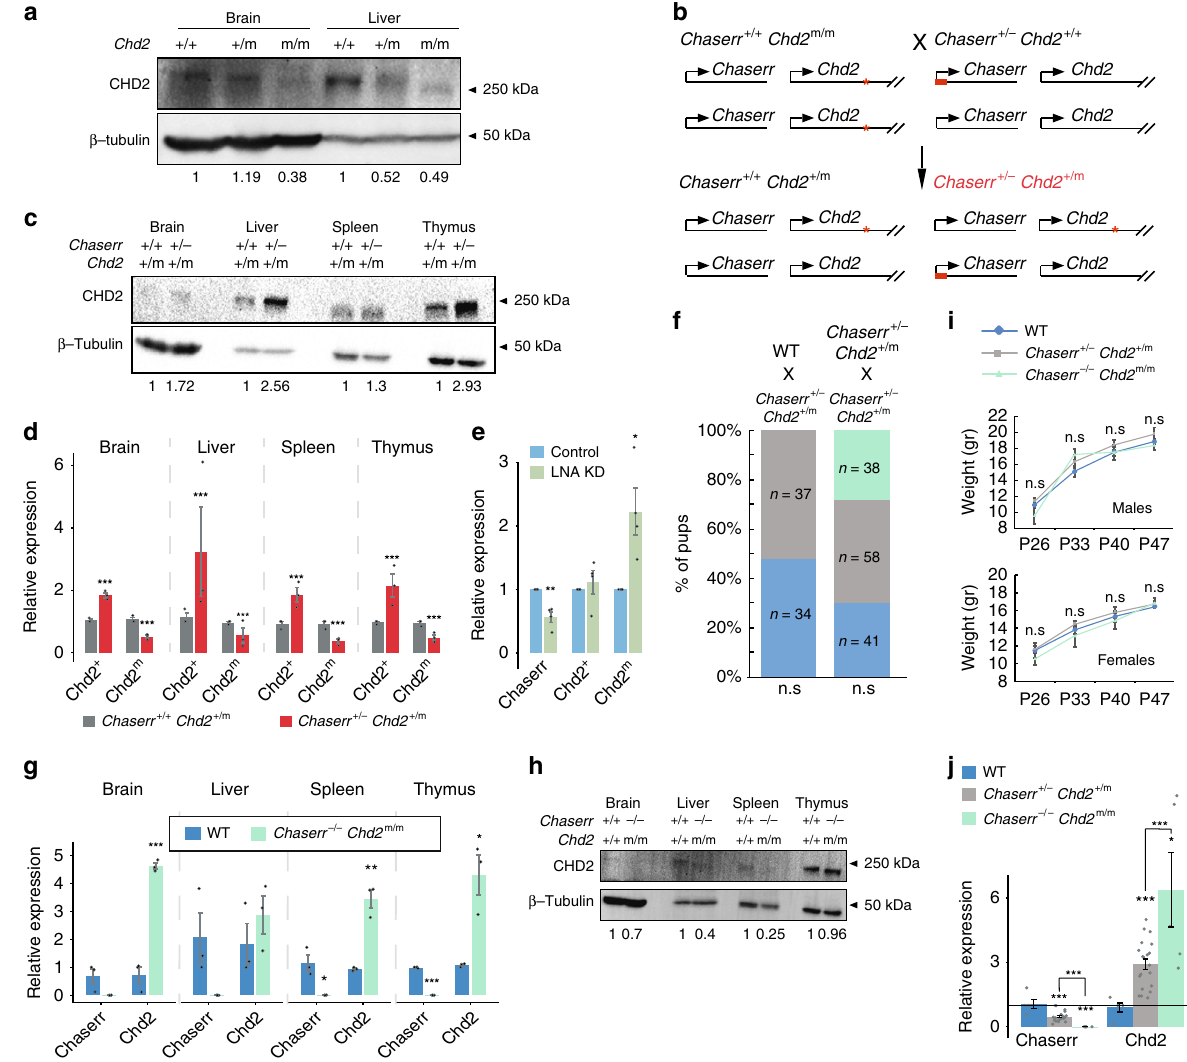
Fig. 3 Chaserr regulates Chd2 expression in cis . a CHD2 Western blot in the indicated tissues from mice with the indicated genotypes. b Scheme of the cross between Chaserr + / − and Chd2 m/m mice. c Western blot in the indicated tissues from mice with the indicated genotypes. d Chd2 allele-speci fi c expression in the indicated backgrounds in four different mouse tissues. Normalized to Actb . n = 3 for the indicated tissues. e Changes in expression of Chaserr , or of Chd2 mRNA from the indicated allele, in Chaserr + / − Chd2 m/ + mEFs transfected with a mix of two LNAs targeting Chaserr or non-targeting control (NT). f Neonate survival rates for the indicated crossing. g qRT-PCR in the indicated adult tissues and backgrounds. Normalized to Actb . n = 3 for the indicated tissues. h CHD2 Western blot from the indicated tissues and backgrounds. i Pup weights for the Chaserr + / − Chd2 m/ + intercross. n = 5 – 19 pups per genotype per time point. j qRT-PCR for mEFs with the indicated background. Normalized to Actb . WT n = 5, Chaserr + / − Chd2 + /m n = 20, Chaserr + / − Chd2 + /m n = 5. Error bars show S.E.M. * P < 0.05, ** P < 0.01, and *** P < 0.001 ( d , e , g , i , j : two-sided t test. f : chi-squared test). Ratio quanti fi cations are shown below Western blots. Source data are provided as a Source Data fi le